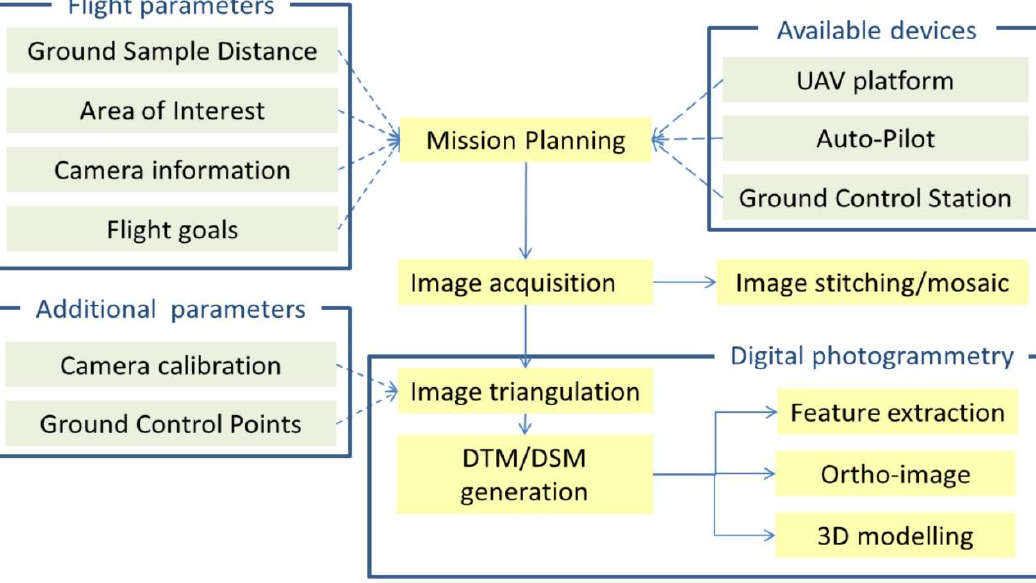
Figure 3. Processing diagram for typical aerial photogrammetry products developed from unmanned aerial vehicle (UAV)-collected data [68].